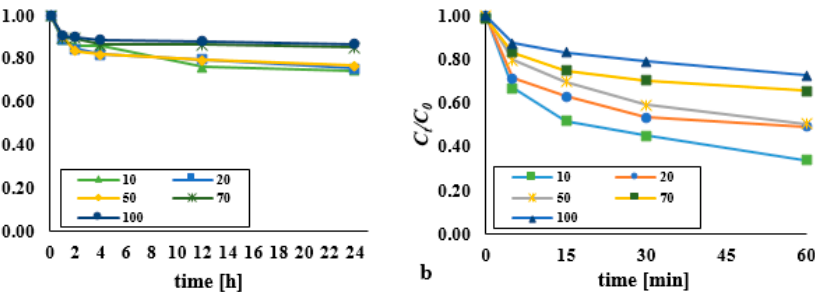
Figure 5. Influence of initial content on the decomposition of DEHP using ( a ) the Fenton